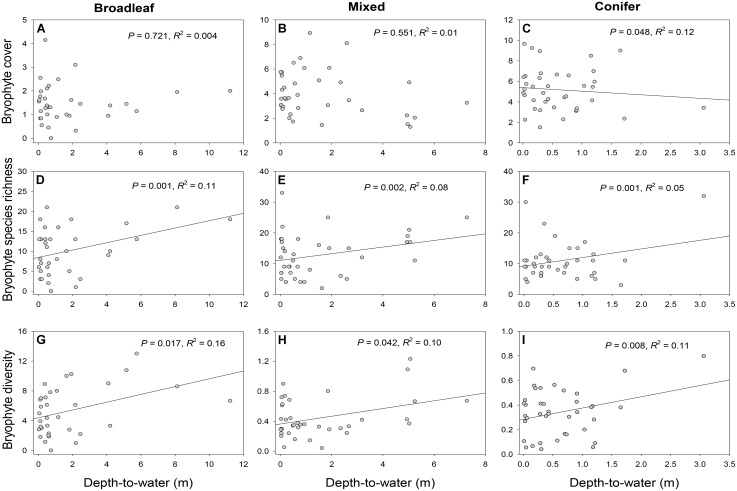
Relationships between depth-to-water (DTW) and bryophyte cover (A–C), richness (D–F) and diversity (G–I) in broadleaf-, mixed, and conifer-dominated boreal forest stands. DTW was based on the 4 ha flow-initiation threshold which produced the best-supported model (based on model AICc and ΔAICc; see Appendix S2). For the analyses bryophyte cover was square root transformed for all forest types (A–C) and bryophyte diversity was log transformed for mixed (H) and conifer forests (I). R-squared (R2) values describe the proportion of variance explained by the fixed factor, i.e., DTW (see Equation 1) alone.